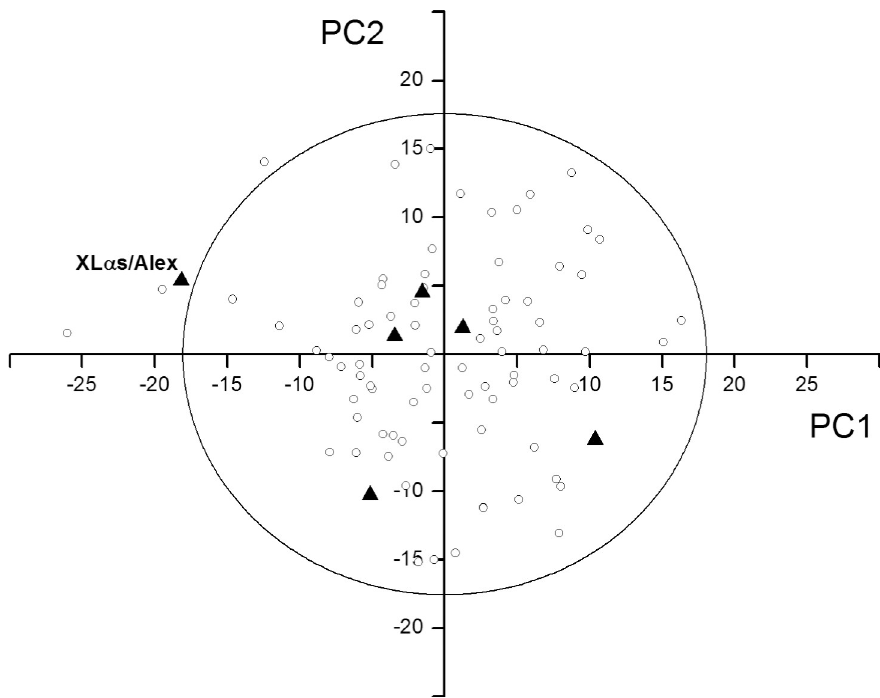
Fig 5. Location of the 6 mammalian overlapping genes in the PC1-PC2 map of viral overlapping genes. The mammalian overlapping genes are indicated by bold triangles, the viral overlapping genes by empty circles. The 3 circles and the triangle outside the ellipse are outliers, that is overlaps with a composition significantly different from the rest (P < 0.05).